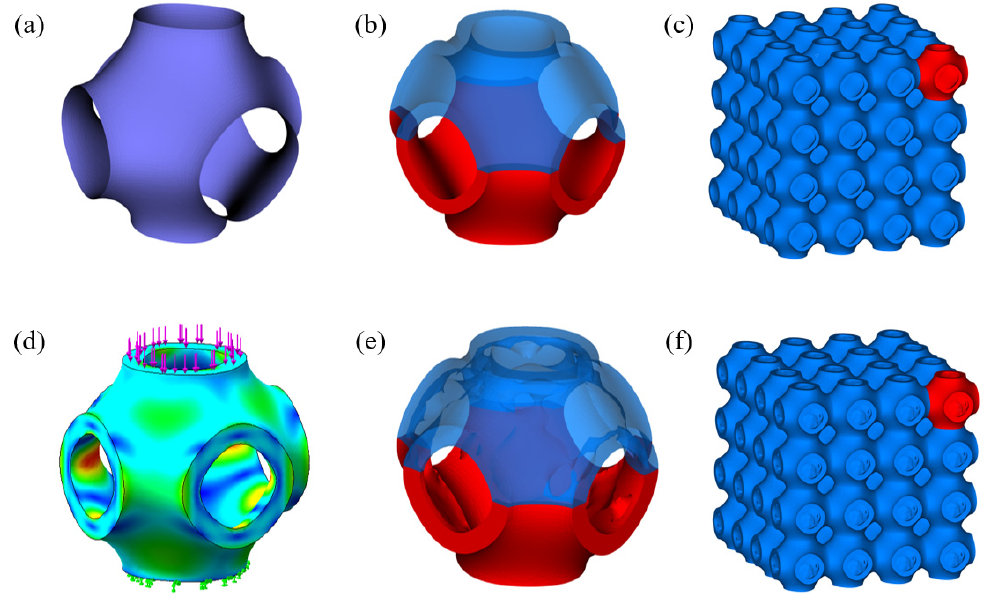
Figure 1. Design of the optimized P-TPMS scaffolds. ( a ) Schwarz Primitive surface; ( b ) P-TPMS unit cell; ( c ) P-TPMS scaffolds with uniform sheet thickness; ( d ) optimized process; ( e ) optimized P-TPMS unit cell; ( f ) P-TPMS scaffolds with optimized thickness.